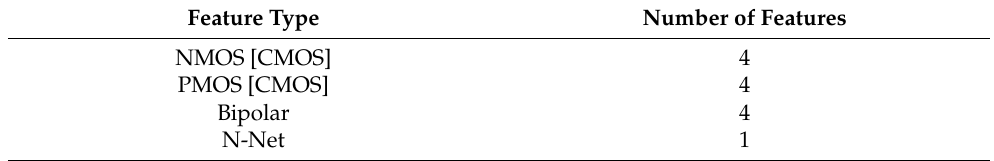
Table 13. Number of features per class while taking into consideration the hyperphysical augmentation.